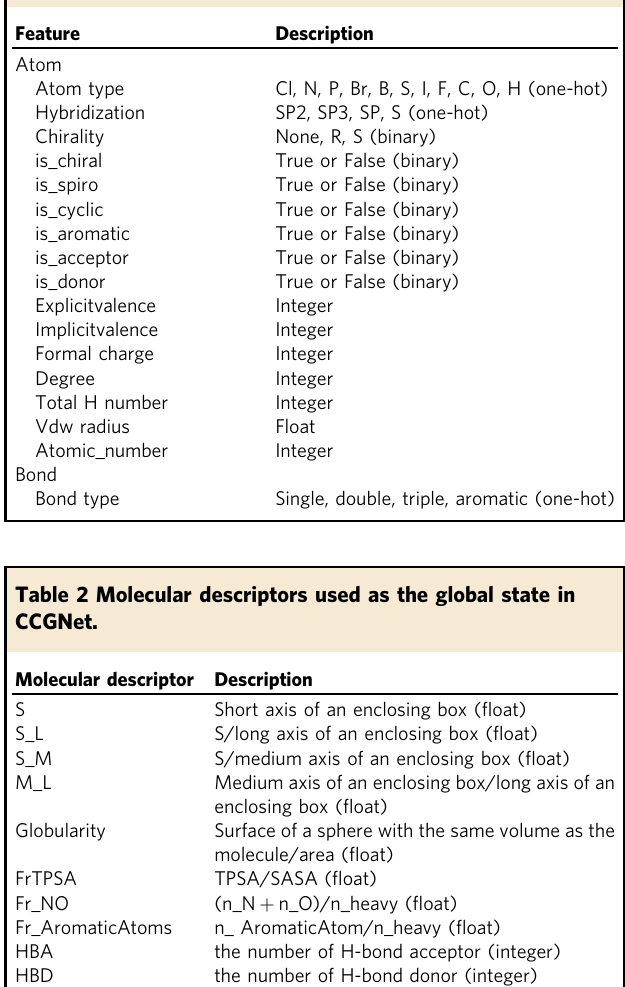
Table 1 Atomic and bond attributes used in CCGNet.